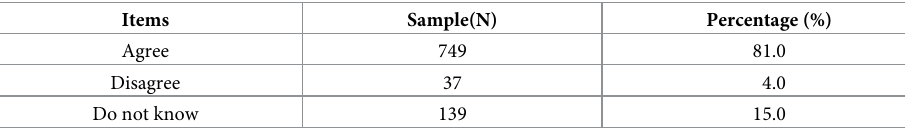
Table 8. Dietary supplements are good for